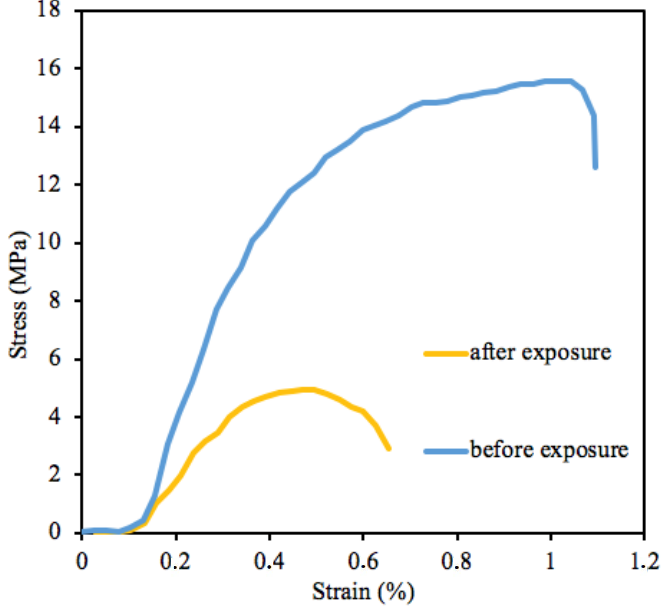
Figure 11. Strain-stress curves of the initial (blue line) and weathered (yellow line) samples. Table 4. Mechanical characteristics of the neat and weathered Hmi /PHB materials (90 days of